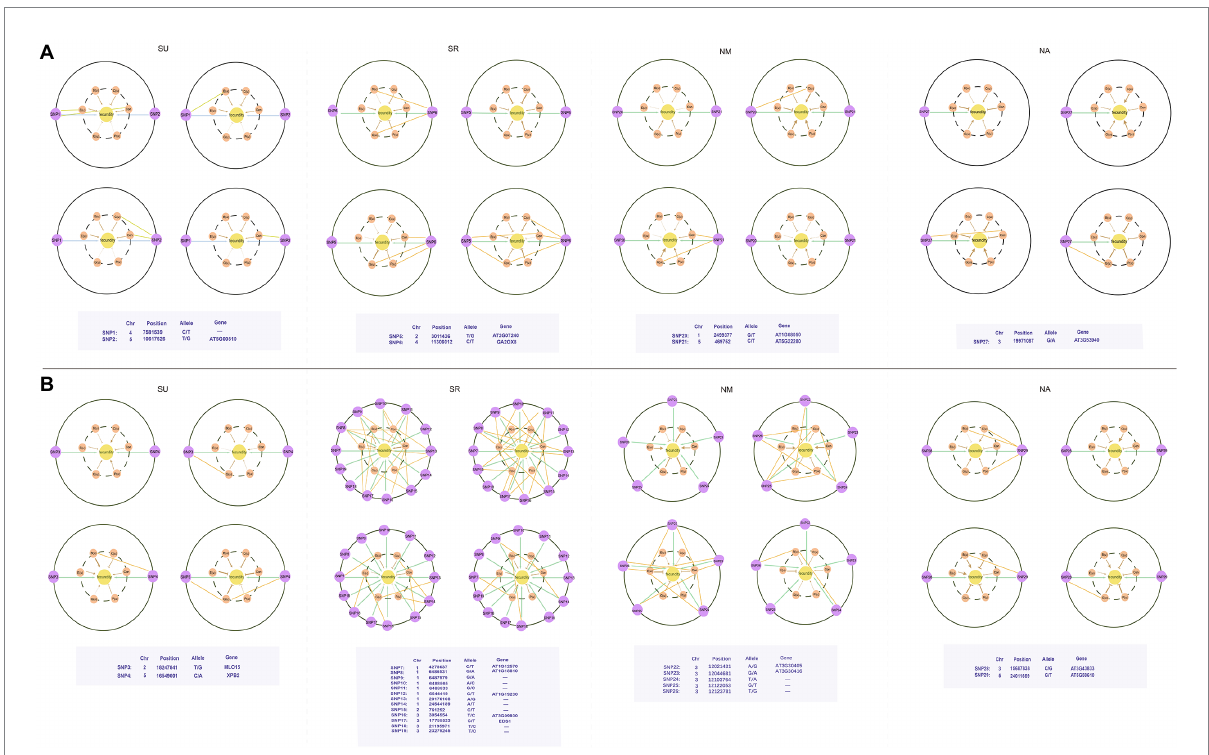
FIGURE 5 Path analysis revealing how QTLs (outer) affect fecundity as a final phenotype (inner) through microbial networks as an “endophenotype” (middle; described by differences of six emergent property indices). (A) The results of four experiments in 2012, (B) The results of four experiments in 2013. Path coefficients are denoted by directed lines from SNPs to fecundity (blue) and from networks to fecundity (brown). Arrowed line and T-shaped line represent a positive and negative impact of path, respectively. Correlation coefficients between SNPs and networks are denoted by blue lines. The thickness represents the magnitude of path and correlation